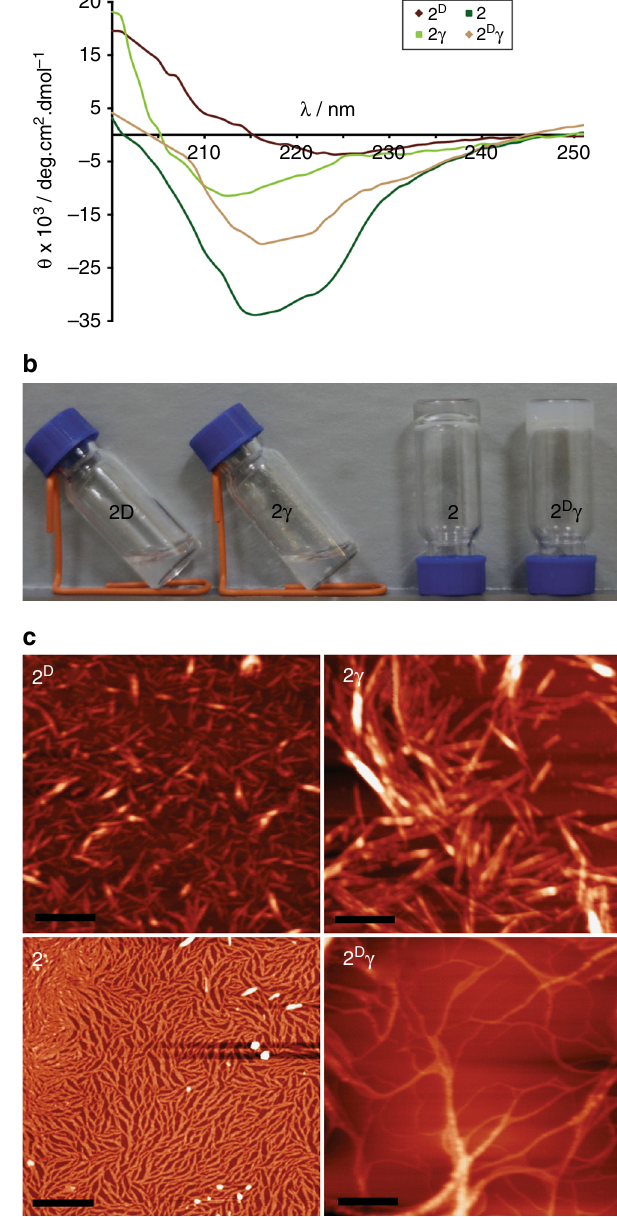
Fig. 3 Structural characterization the four isomeric peptides 2 , 2 D , 2 γ , and 2 D γ formed spontaneously during the ligation reaction. a CD spectra of 50 ± 2 µ M peptides at pH 7. b Gelation analysis for 5.6 mM aqueous solutions at pH 7. c AFM images of the self-assembly products formed in 50 ± 2 μ M solutions. Samples were drop cast on a mica surface after 10 min of sonication, followed by 30 min of equilibration in MOPS buffer, pH 7. All scale bars are 1 μ m